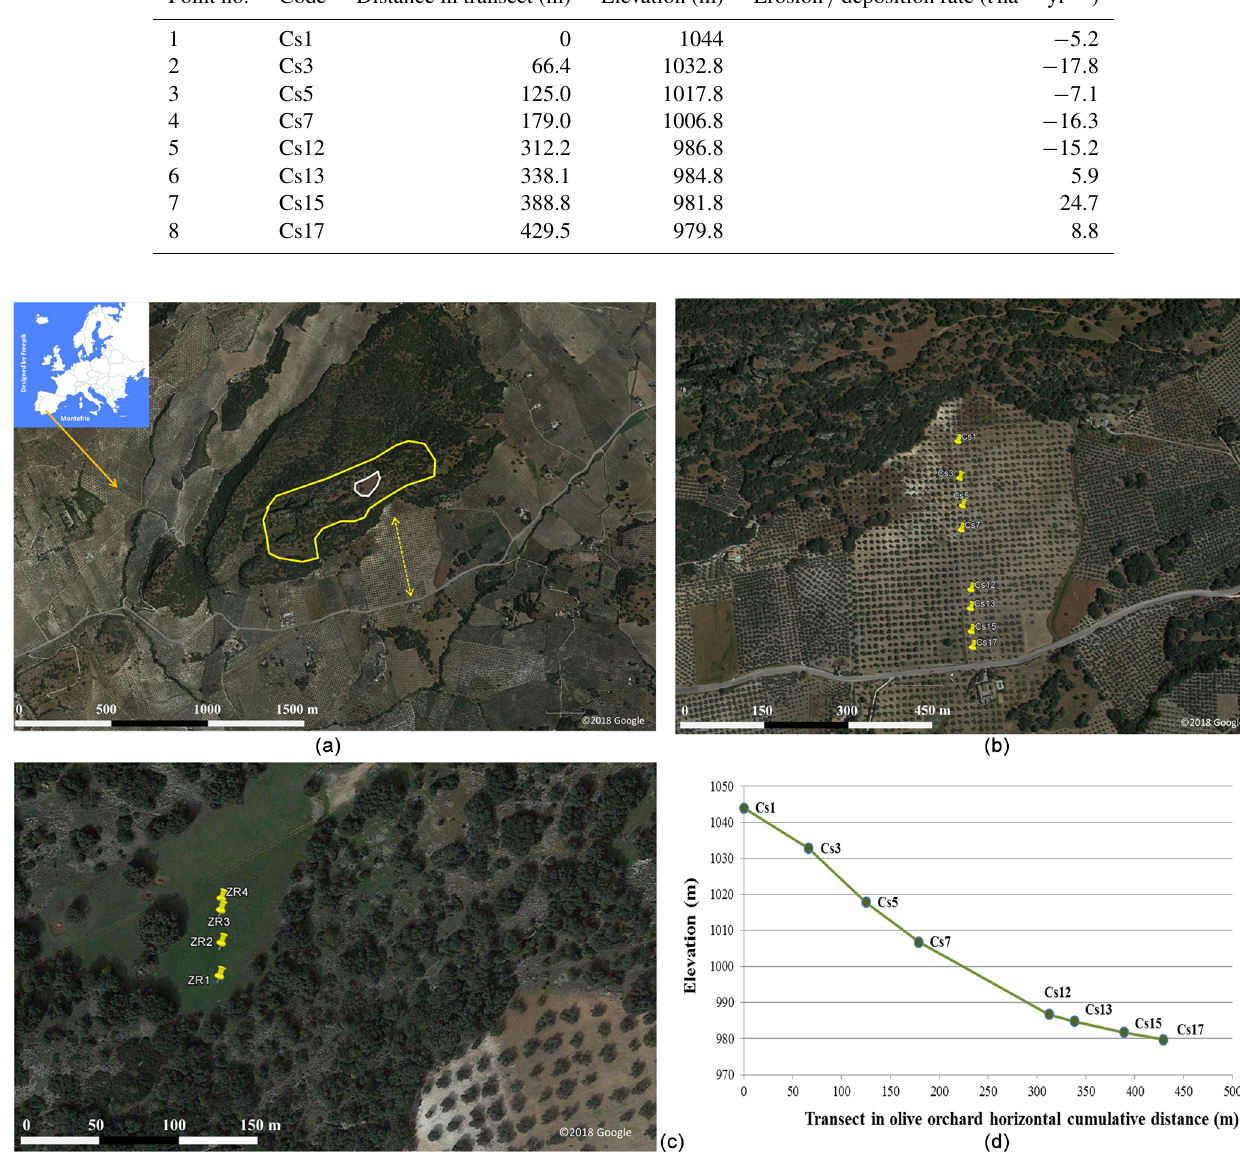
Table 1. Location of the sampling points along the transect and associated soil redistribution rates derived from the 137 Cs technique (adapted from Mabit et al., 2012). Negative values indicate net erosion and positive values net deposition.